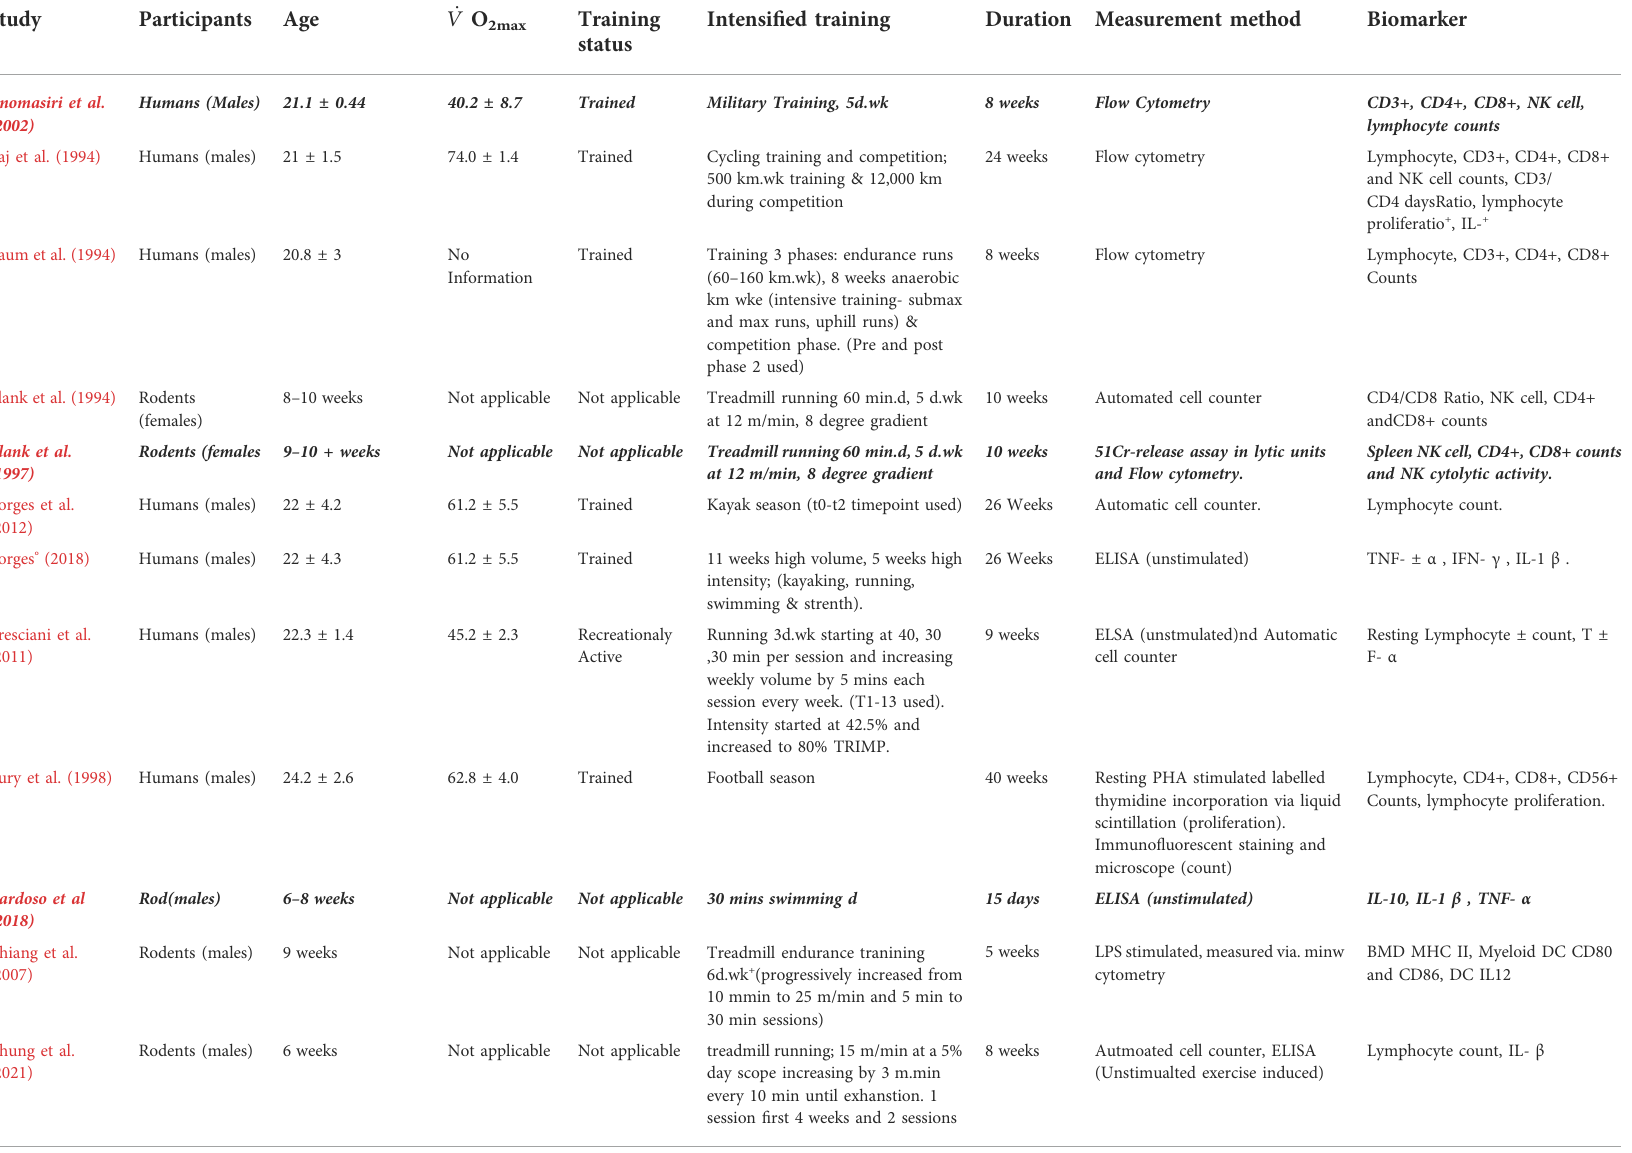
TABLE 2 Return of relevant studies from the systematic search. Studies in Bold Italics were eligible for inclusion from the systematic search, but were not suitable for inclusion into the